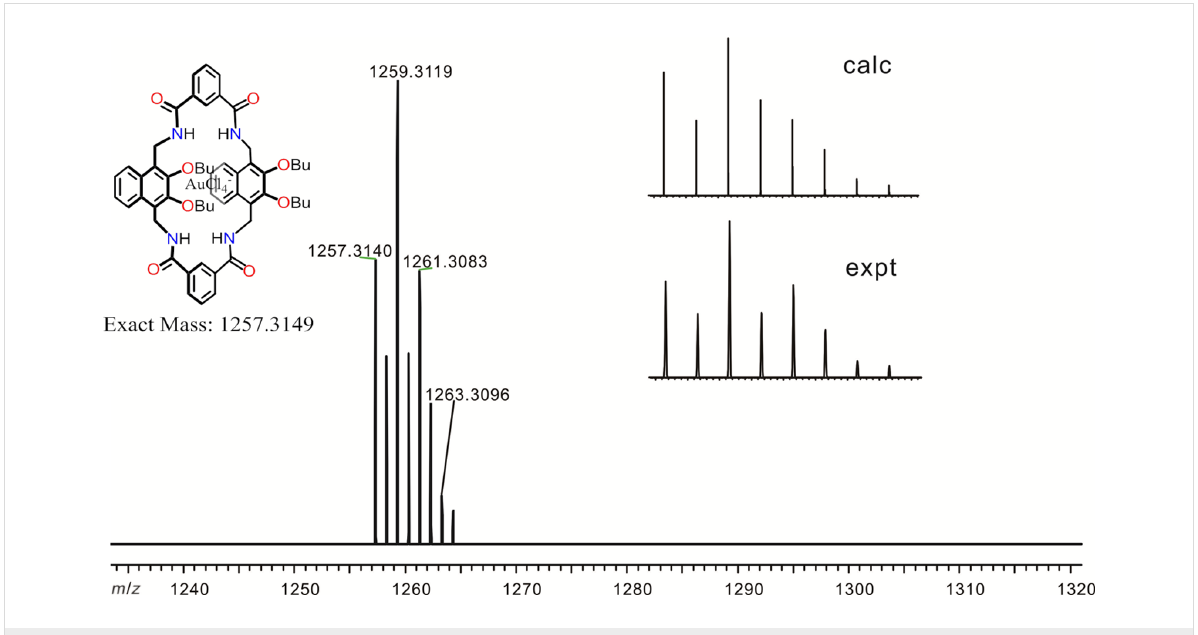
Figure 4: ESI mass spectrum of complex AuCl 4 − @ 1